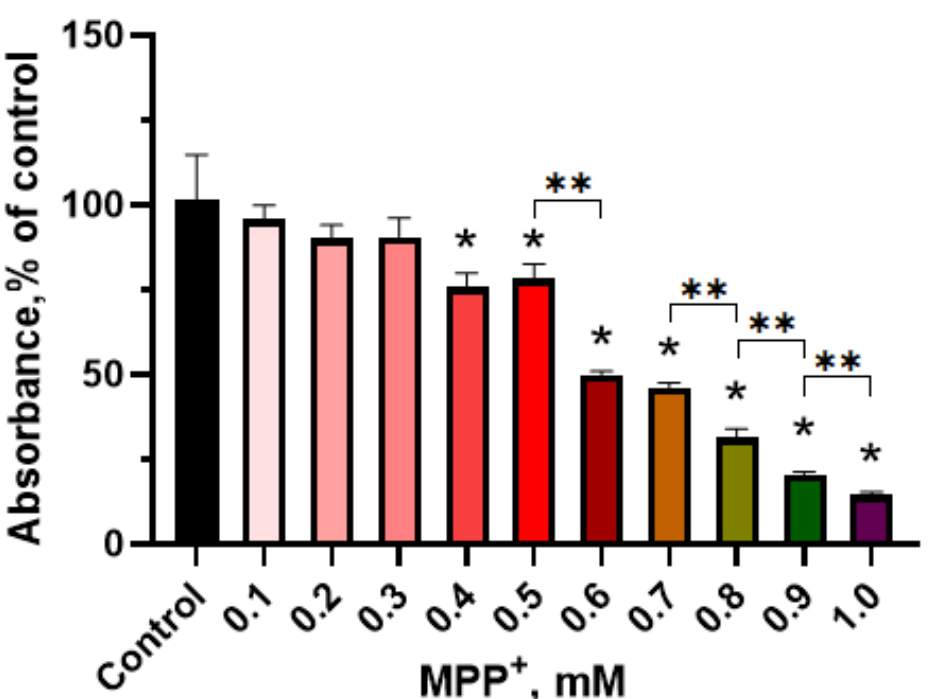
Figure 7. Formazan absorption resulting from 3-(4,5-dimethylthiazol-2-yl)-2,5-diphenyltetrazolium bromide (MTT) reduction in differentiated LUHMES cells after their incubation for 48 h with 1-methyl-4-phenylpyridinium iodide (MPP + ) at doses from 0.1 up to 1.0 mM. * p < 0.05, significant difference compared to the control, ** p < 0.05, significant difference between the selected groups.